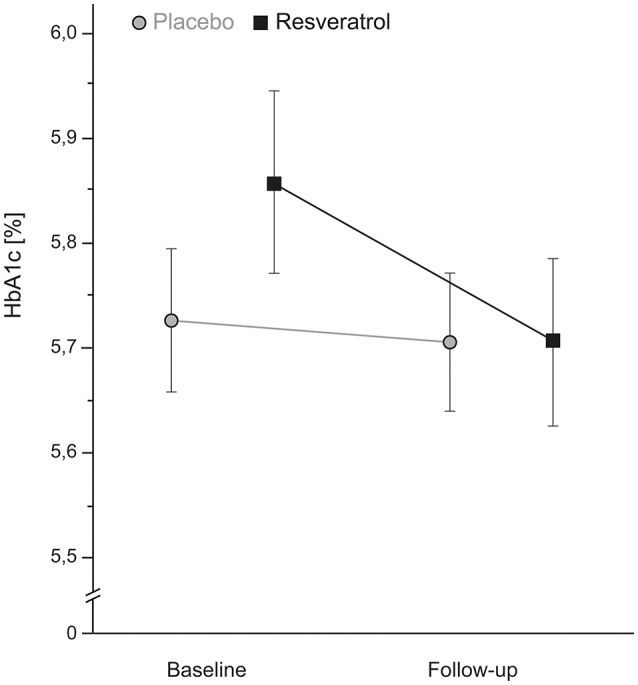
A moderate, but non-significant decrease in the long-term glucose marker HbA1c after 26 weeks resveratrol intervention (n = 18) compared to placebo intervention (n = 19) (ANCOVARMp = 0.059, d = 0.66). The decrease reached statistical significance when analyzing the resveratrol group separately (paired t-test p = 0.005). HbA1c, glycated hemoglobin A1c.